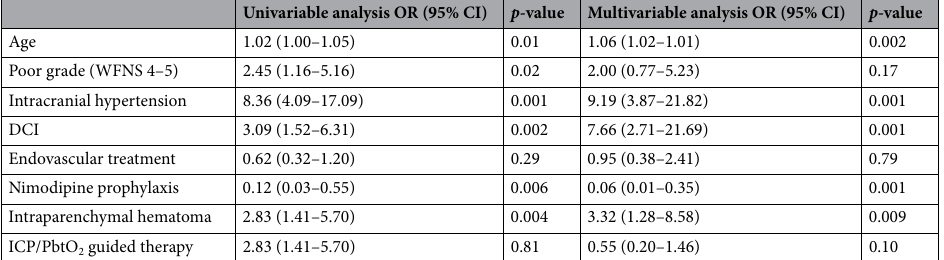
Table 2. Logistic regression analysis to identify variables independently associated with 6-month unfavorable neurologic outcome. Data are reported as odds ratio (OR) and 95% confidence intervals (CIs). WFNS world federation of neurological surgeons, ICP intracranial hypertension, PbtO 2 brain tissue oxygenation, DCI delayed cerebral